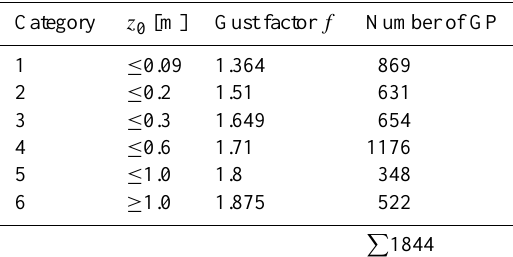
Table 2. Empirical gust factors as a function of roughness length, z 0 , with the corresponding gust factor, f , and the number of grid points (GP) in each